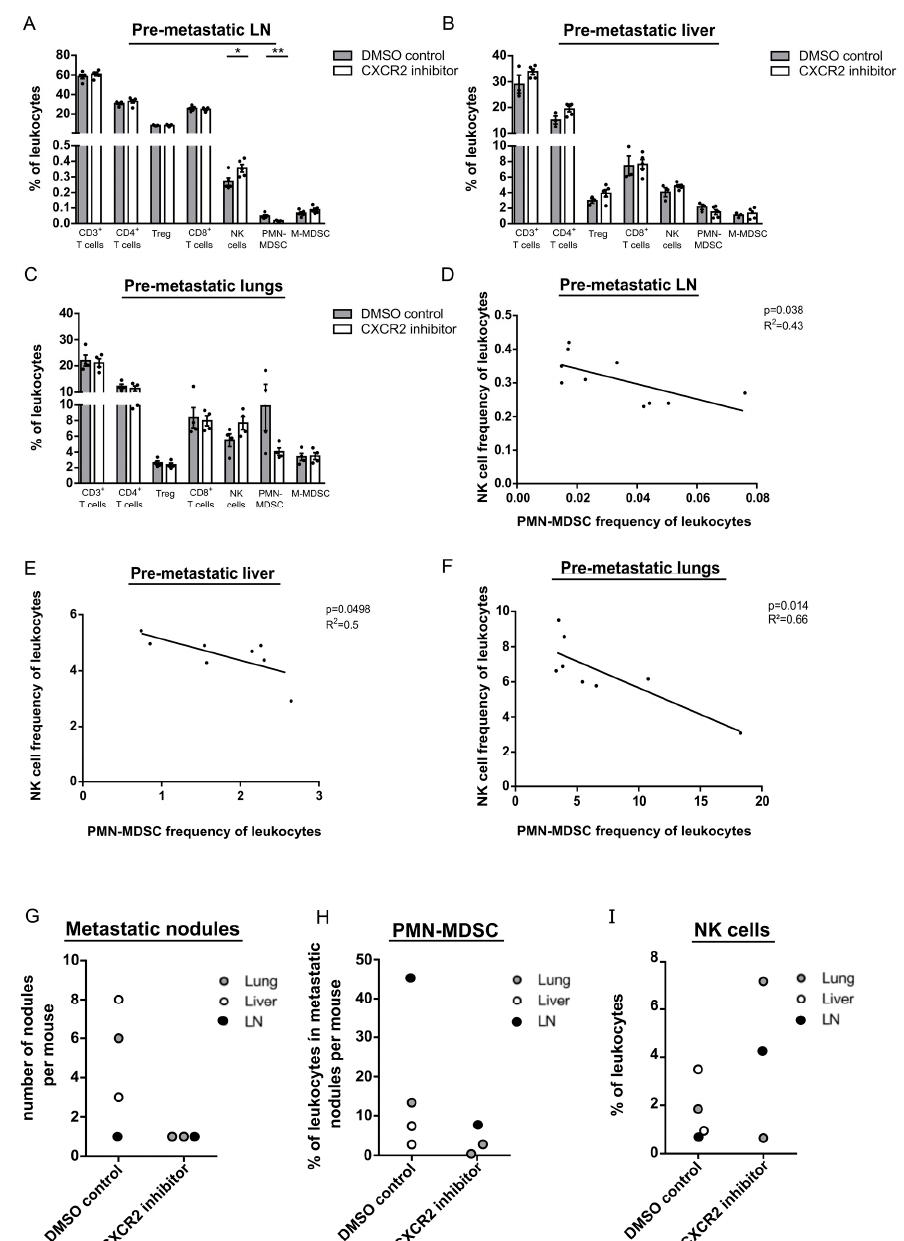
Figure 7. Anti-CXCR2 therapy impairs PMN-MDSC migration to pre-metastatic sites and metastasis in LN, liver, and lungs. C57BL/6 mice were transplanted intradermally with the fragments of primary tumors from RET transgenic mice followed by tumor resection at day 21 after transplantation. At day 7 after resection, mice were injected i.p. with the CXCR2 inhibitor SB265610 (2 mg/kg) or the control DMSO solution (control group) twice a week for four weeks. ( A – C ) One day after the last injection, CD3 + , CD4 + , and CD8 + T cells, Treg, NK cells, PMN- and M-MDSC were measured in pre-metastatic LN ( A ), liver ( B ) and lungs ( C ) by flow cytometry. Data are presented as the percentage of respective subpopulations within CD45 + leukocytes (mean ± SEM; 3–5 mice/group). The percentage of PMN-MDSC among CD45 + leukocytes infiltrating pre-metastatic LN ( D ), liver ( E ), or lungs ( F ) were plotted against the percentage of tumor infiltrating NK cells within CD45 + leukocytes in these organs from respective mice ( n = 8–10). The correlation was evaluated by a linear regression analysis. One day after the last injection, macroscopic metastatic nodules in LN, lungs, and liver were counted ( G ). Data are shown as number of nodules per mouse. The frequency of PMN-MDSC ( H ) and NK cells ( I ) infiltrating metastatic nodules in LN, lungs, and livers were measured in each nodule per mouse by flow cytometry and presented as the percentage of respective cell populations among CD45 + leukocytes. * p < 0.05, ** p <